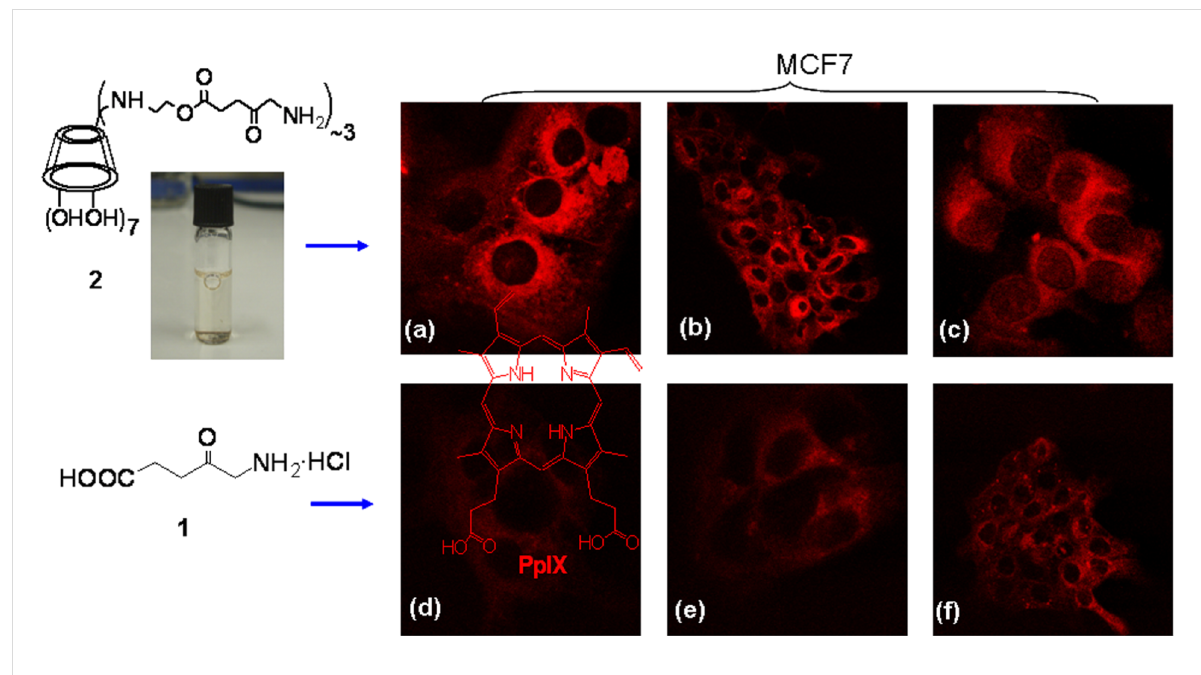
Figure 2: Representative confocal microscopy images of MCF7 cells incubated with 1 mM 2 (a, b and c), and 1 mM 1 (d, e, f), ( λ ex = 568 nm, λ em > 585 nm). The laser intensity used for the acquisition of images a, b, c was 30% of that used for images d, e and